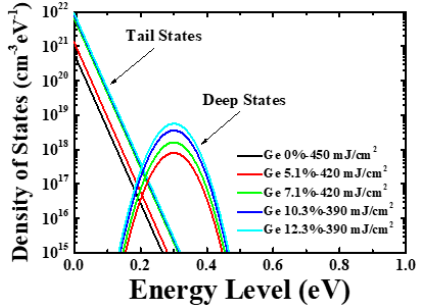
Figure 7. Distribution of density of states (DOS) as a function of the laser energy density and Ge concentration. Ge